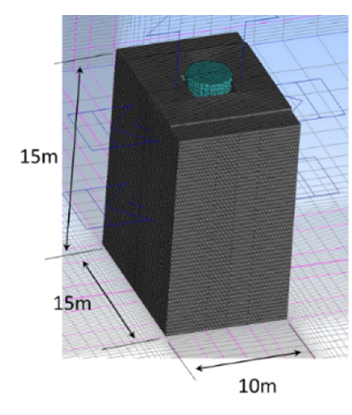
Figure 3 . Analysis model and computed domain in the case of a single cooling tower ( a ) and eight towers ( b ). 3.2.2 . Wet Operation Figure 4 shows the initial and boundary conditions used in this calculation. In wet operation, measured velocity distributions, temperature and moisture were given as the boundary conditions. The velocity distribution at the exit of the fan was measured using model equipment with a fan diameter of 580 mm by Takata et al. [8]. Figure 5 shows the measured velocity distributions obtained by a laser doppler velocimeter at the outlet of the exhaust fan. The velocities in three directions are normalized by the peripheral tip velocity of the rotating fan, and the positions of measured velocities are normalized by the radius of the fan. The measured velocity profile was assumed to be similar to that of the actual tower. The use of measured velocities as a boundary condition is considered to be effective in accurately predicting the effect of radial and circumferential direction flows produced by the rotating fan. However, although it would be ideal to solve the velocity distributions generated by the rotating fan, it is difficult to obtain the detailed velocity distribution through CFD analysis applying a moving boundary problem to the fan. Therefore, for simplification of the calculation, the measured velocity distribution was used. Additionally, measured outside air temperatures (dry bulb temperature and wet bulb temperature, hereafter DBT and WBT), moisture surrounding the cooling tower and wind velocity shown in Figure 5 and Table 1 were given as the initial and boundary conditions in the computational domain.